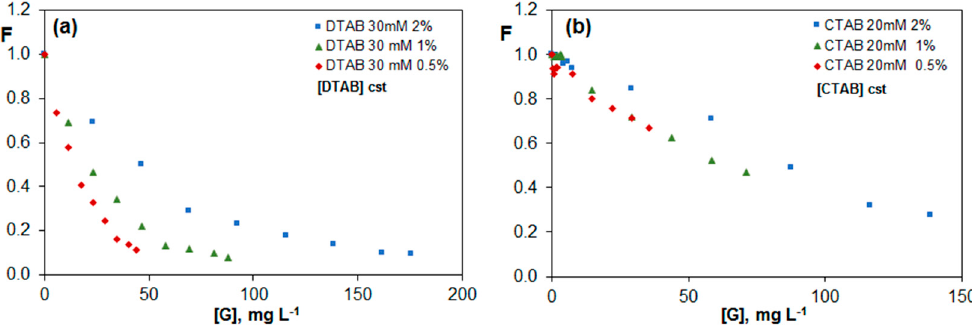
Figure 8. Fluorescence of vitamin B 2 (F) vs. G concentration for G dispersions in 30 mM DTAB ( a ) and 20 mM CTAB ( b ) for solutions with a constant surfactant concentration. 20 mM CTAB ( b ) for solutions with a constant surfactant